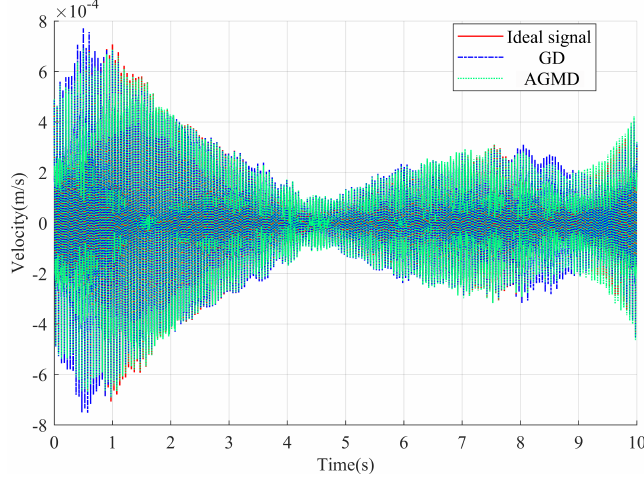
Figure 12. Comparison of velocity time history curves after the algorithm denoised 30% noise energy.